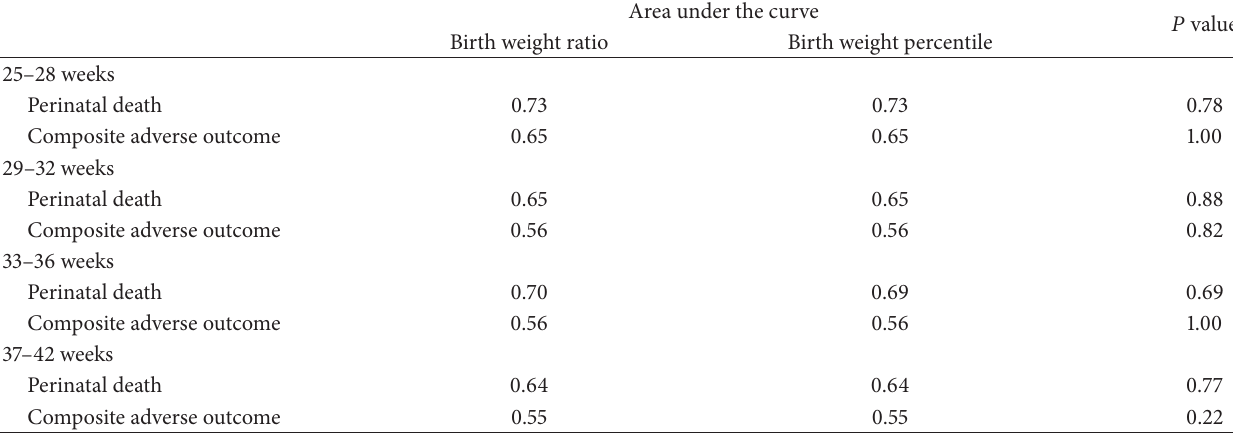
Table 3: Discriminative ability to predict perinatal death or adverse outcome of birth weight ratio and birth weight percentile.